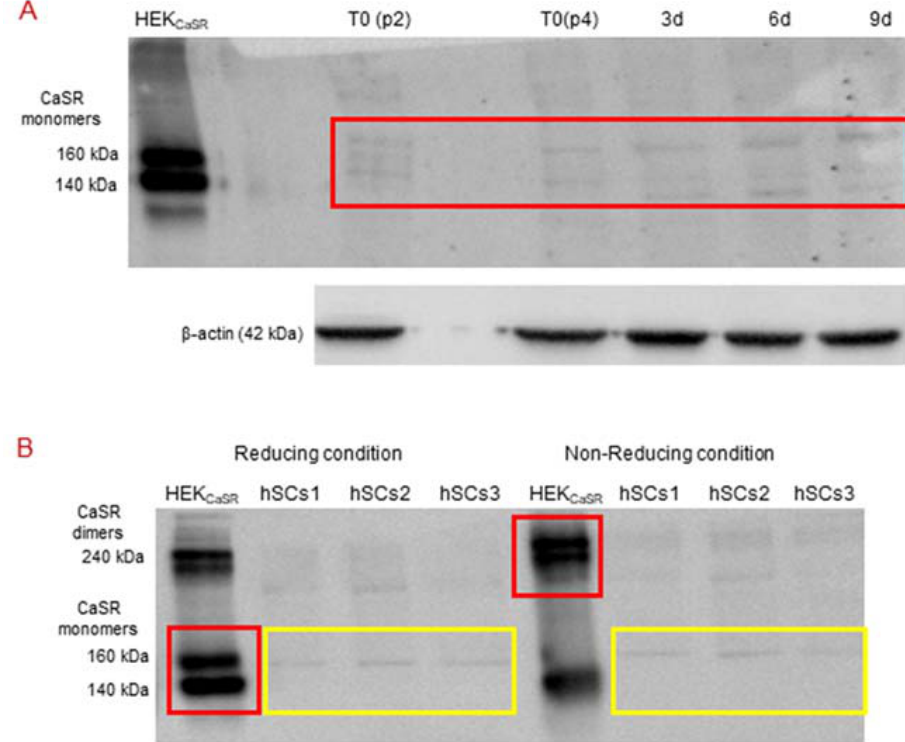
Figure 5. ( A ) Western Blot (standard reducing condition) for CaSR protein in hSC lines and during myogenic differentiation. The results show the presence of faint bands of about 160 kDa and 140 kDa in hSC lines and at different time points (T 0 , 3, 6, 9 days of myogenic differentiation) of primary hSC lines. HEK CaSR were used as positive control. Experiments were carried out in triplicate and are representative of the three established hSC lines. ( B ) Western blot analysis of CaSR in reducing and non-reducing conditions. The analysis for CaSR protein in three hSC lines showed that the observed bands are not CaSR as they did not shift to dimer form at 240 kDa in non-reducing conditions. HEK CaSR were used as positive control. The red and yellow boxes surround the analyzed bands.